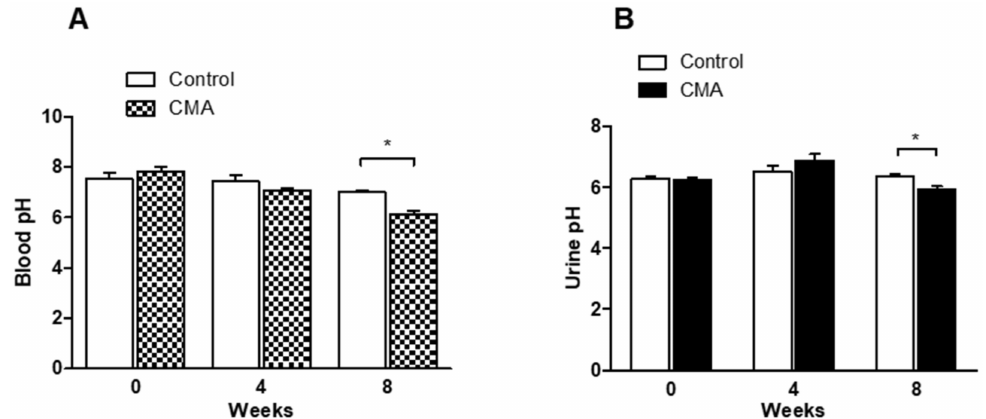
Figure 2. Blood ( A ) and urine ( B ) pH measurements. Each bar represents values expressed as mean ± SEM. The change in pH was considered significant (*) when p < 0.05 between two groups. The data were analyzed using two-way ANOVA followed by Bonferroni posttests. Measurement of blood pH ( A ) and urine pH ( B ) in control and chronic metabolic acidosis (CMA)